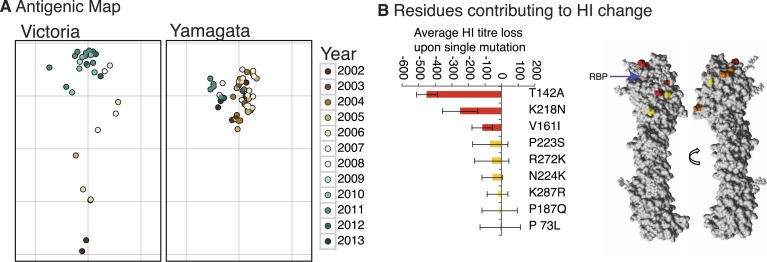
Antigenicity of influenza B viruses.Antigenic map showing relative antigenic differences of Victoria and
Yamagata lineage viruses (circles) measured using the hemagglutinin
inhibition (HI) assay for each strain and coloured by year of isolation
(A). Residues contributing to HI titer changes
(B). Among the nine amino acid changes that we detected
between antigenically different Victoria viruses, three changes produced
strong HI titer change (>100) (red), 3 medium (≈50) (orange)
and 3 low (<20) (yellow). Changes that produced the strongest HI
titer change were the closest to the receptor binding pocket (blue arrow),
highlighting the significance of their proximity to HI titer change. Amino
acids were mapped on previously resolved influenza B virus structure
(PDB:4FQM). Detailed HI titer values and reference antigens used are
provided in the Dryad source data (Vijaykrishna et al., 2015).